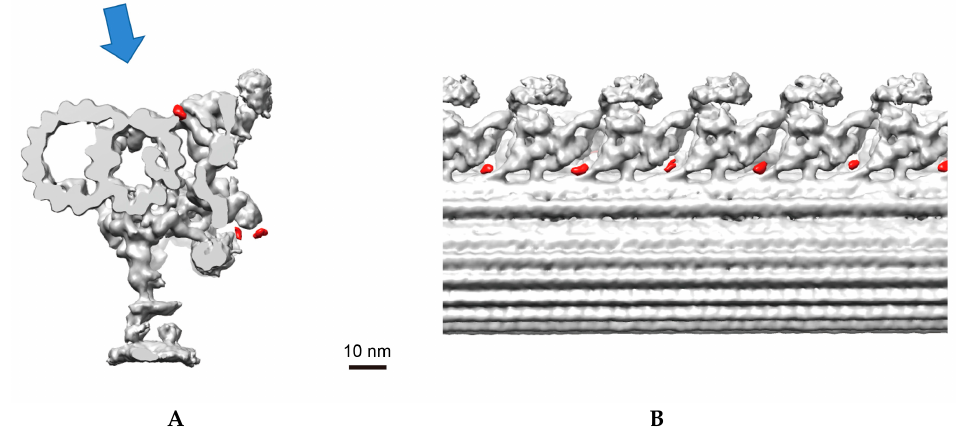
Figure 6. Analysis of the localization of FAP70 protein by cryo-electron tomography. ( A ) A cross- sectional view of one out of nine doublet microtubules of the axoneme. The flagella of the fap70 mutant rescued by FAP70-N-BCCP were purified, and the axoneme was labeled with streptavidin and biotinylated cytochrome c to increase the density of the BCCP tag. The resulting three-dimensional (3D) structure of the subject by cryo-electron tomography was compared with the wild-type reference data, and the tag densities found only in the subject are labeled in red. The arrow indicates the direction of the views in B . ( B ) Longitudinal view. The tag densities were located at the base of the ODAs.